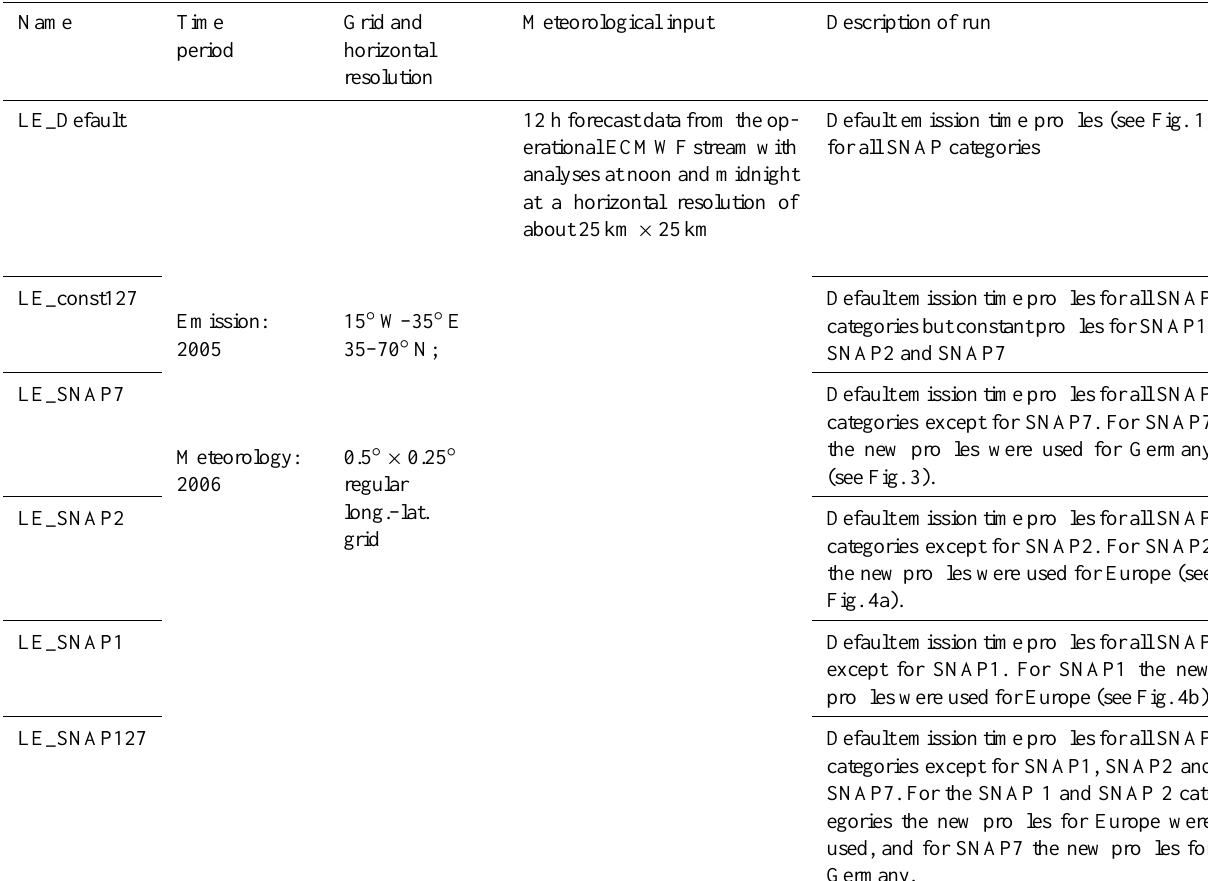
Table 2. Description of the model